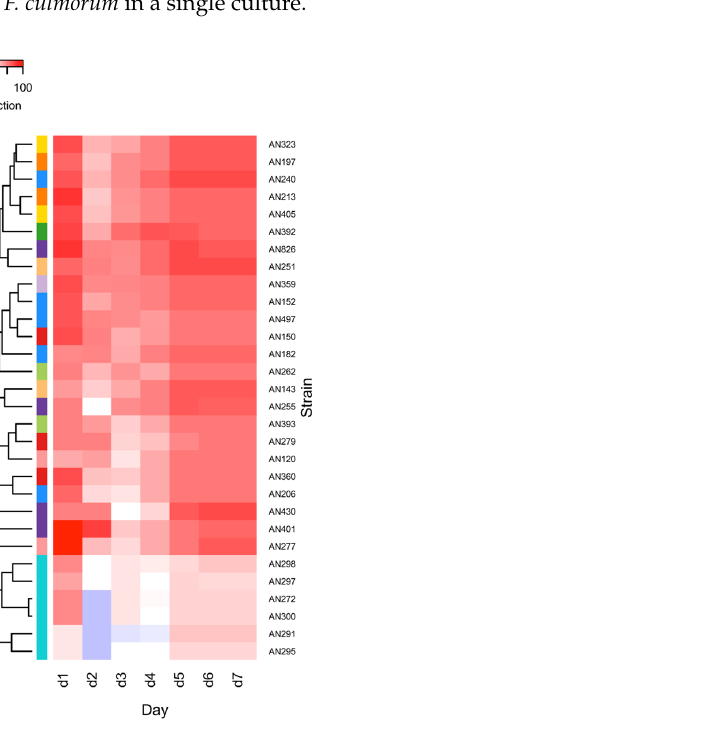
Figure 2 . Heat map of F. culmorum KF846 mycelial growth inhibition (%) induced by Trichoderma or Clonostachys strains during 7 days of co–incubation in dual cultures on PDA medium.